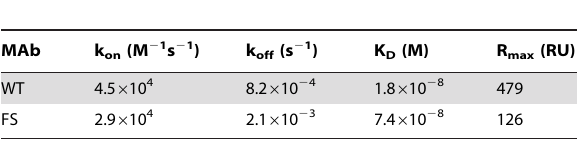
Table 2. Kinetic rate constants k on and k off of antibody wild type and Variant FS binding to Fc c